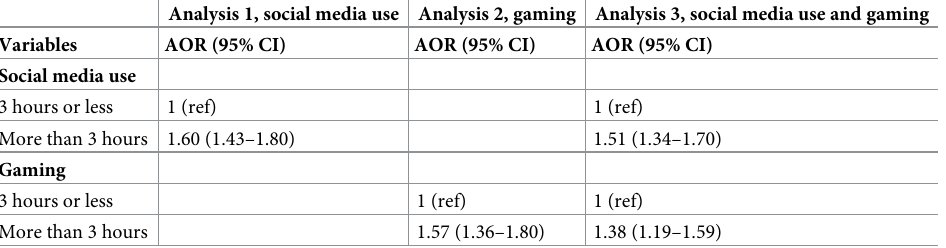
Table 3. Binary logistic regression analysis of symptoms of depression in relation to social media use and gaming, controlling for possible confounders factors (Ungdata 2018, adolescents aged 15–16 years).